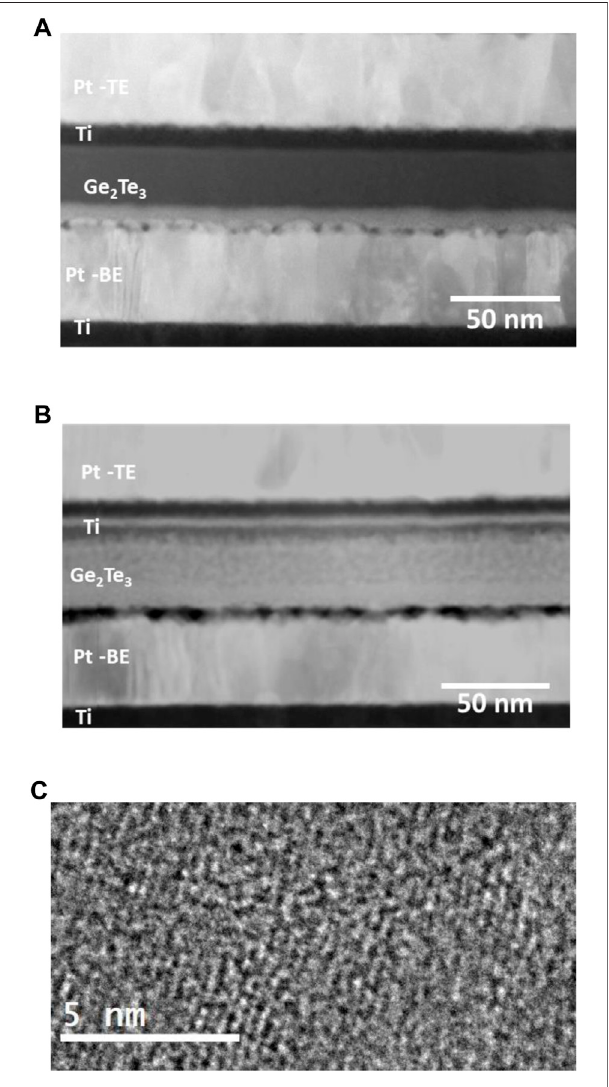
FIGURE 6 | HAADF-STEM images showing the overall device structure in (A) as-grown condition at room temperature, (B) after heating to200 ° Cand (C) HRTEM image of Ge 2 Te 3 after heating to 200 ° C.